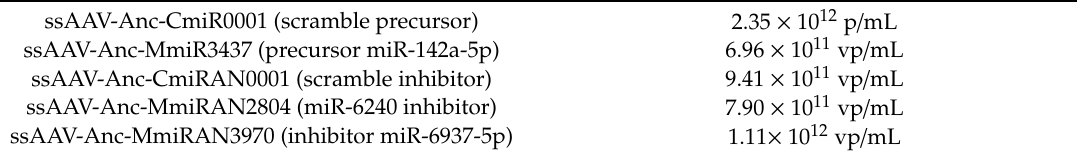
Table 1. Titration of AAV vectors employed.